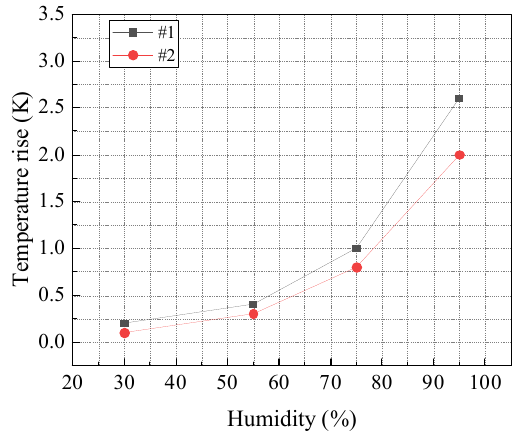
Figure 4. Temperature rise curve in sample #1 and #2.